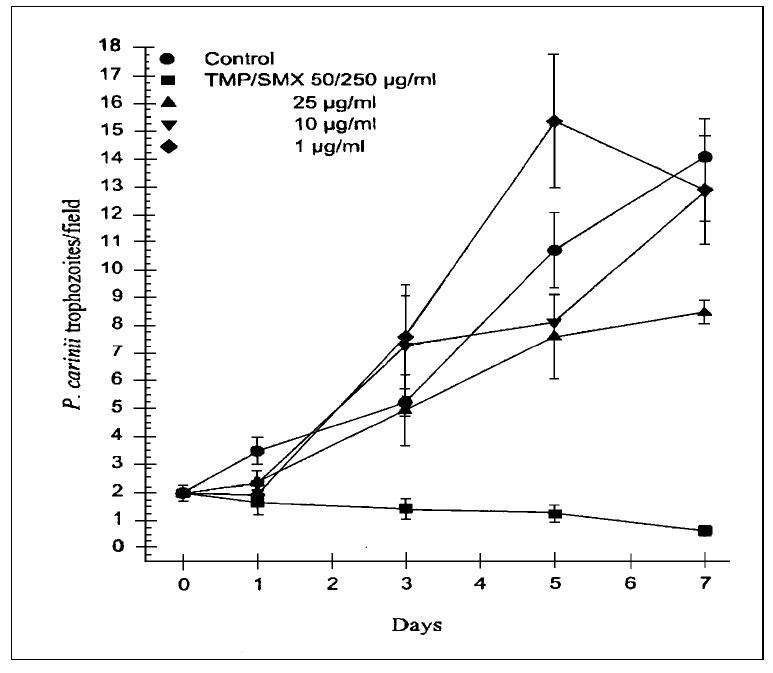
Figure 5. Inhibition of the growth of Pneumocystis carinii by the trisoxaziridine